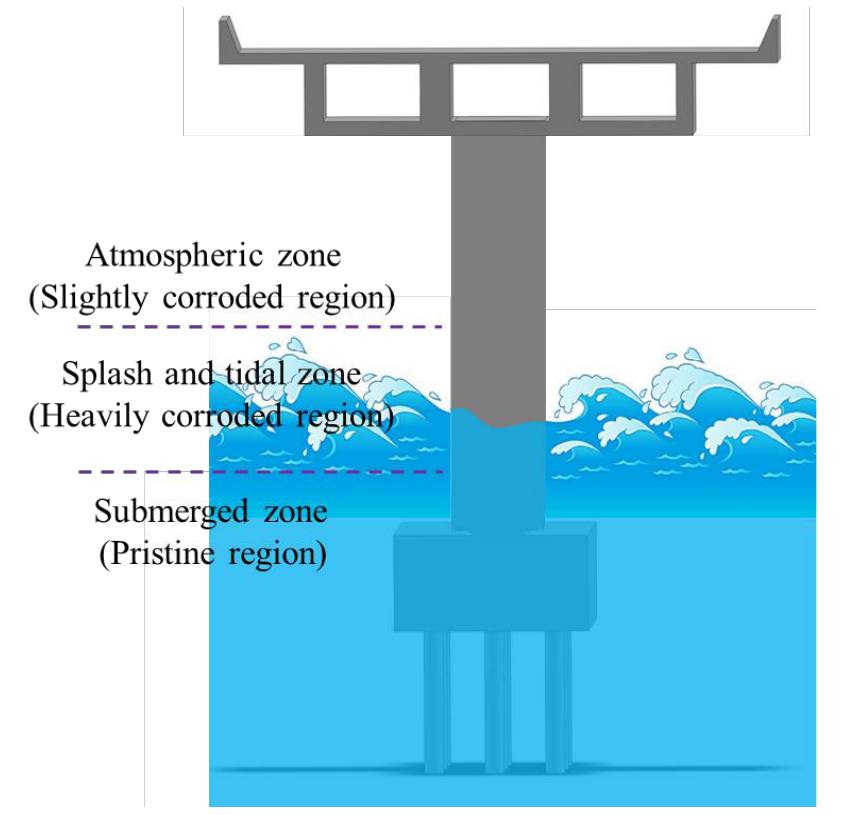
Figure 1. Schematic of the coastal bridge pier subjected to nonuniform corrosion.